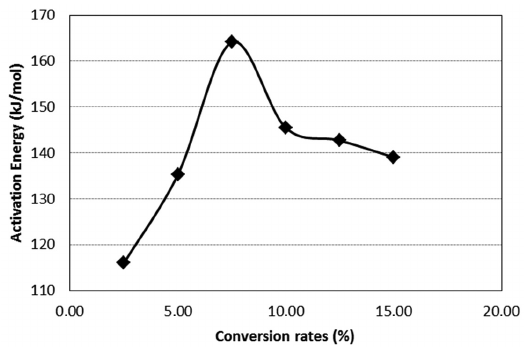
Figure 10. Activation Energies obtained for the conversion rates of 2.5%, 5.0%, 7.5%, 10.0%, 12.5% and 15.0%.